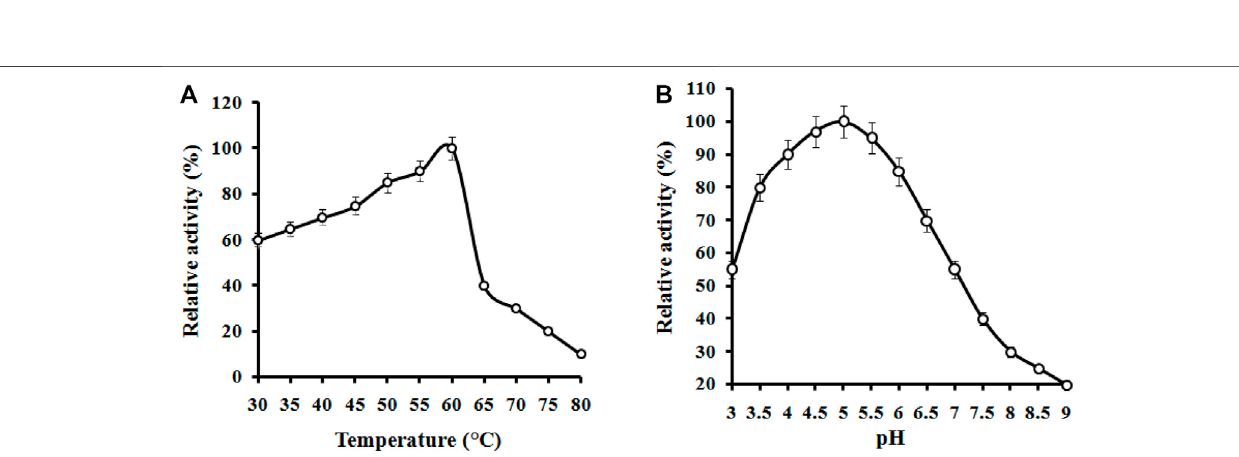
Different peptides of the master protein (cellulase) were identi fi ed on modi fi cations